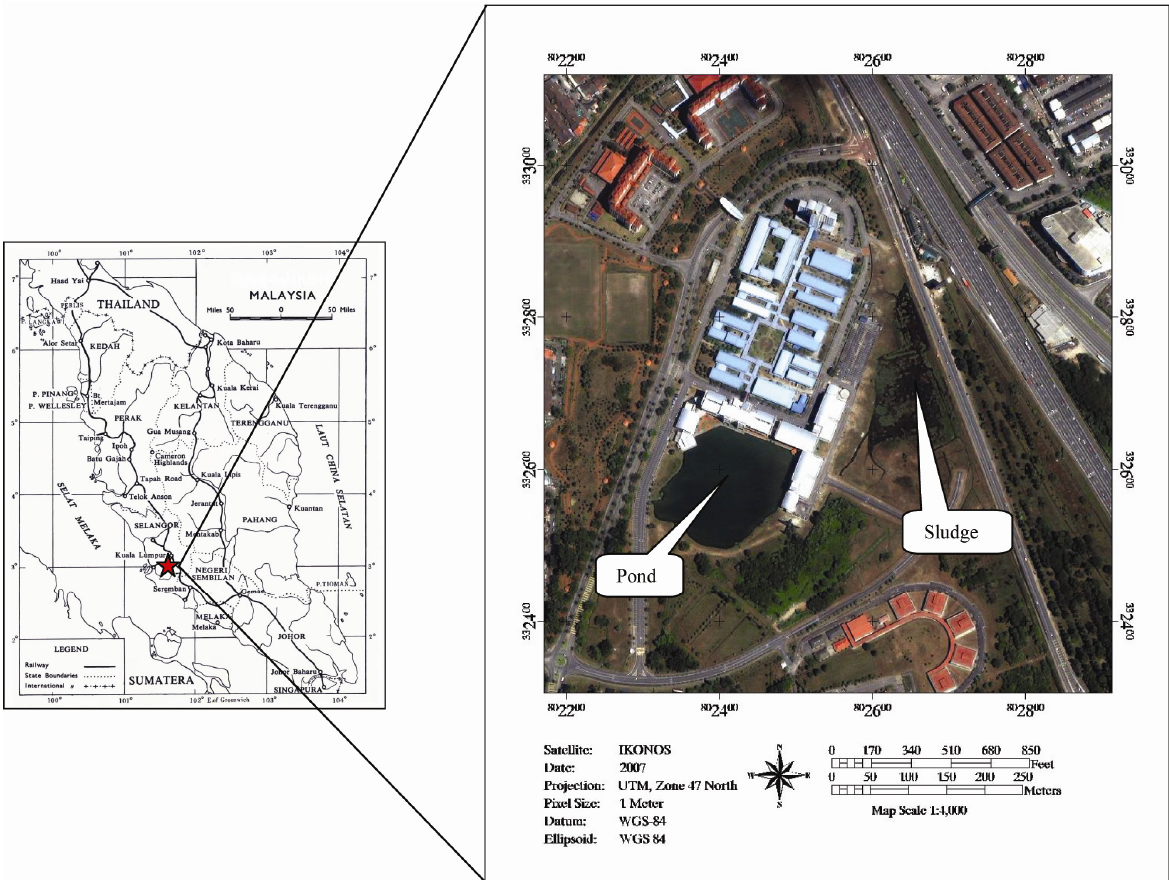
Fig. 1. General view of the study